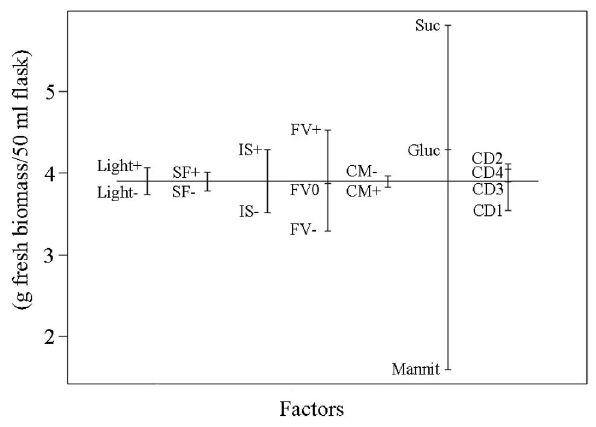
Figure 3. Biomass model plot. The abbreviations are the same as in Table 1.